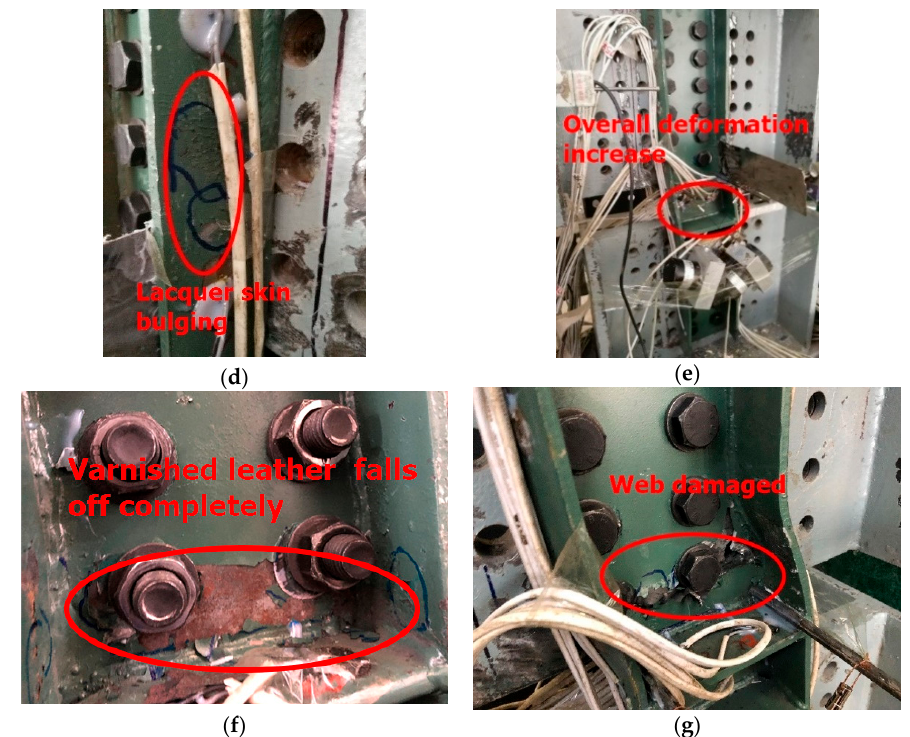
Figure 6. Failure modes of RSL-1. ( a ) vanished leather bulging; ( b ) vanished leather bulging; ( c ) flange bending; ( d ) lacquer skin bulging; ( e ) overall deformation increase; ( f ) vanished leather falls off; ( g ) web damaged.